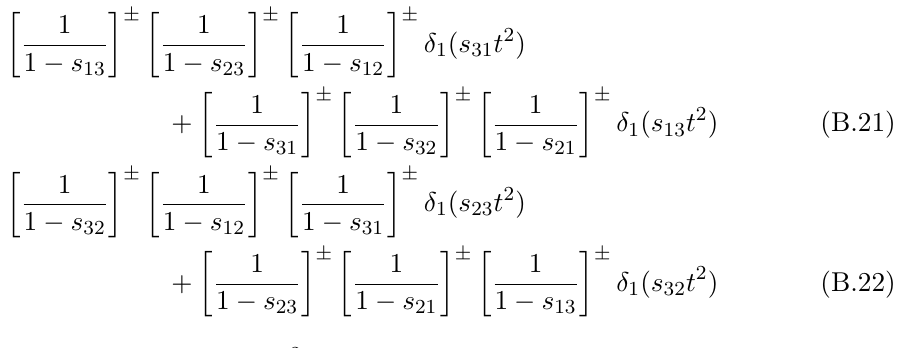
Figure 5 . Pictorial representation of the coe(cid:14)cients of t 2 n , n (cid:21) 0, coming from the two terms in